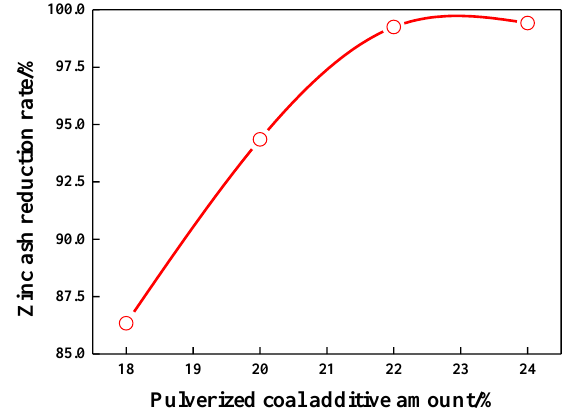
Figure 8. Effect of coal additive amount on reduction rate of zinc ash.